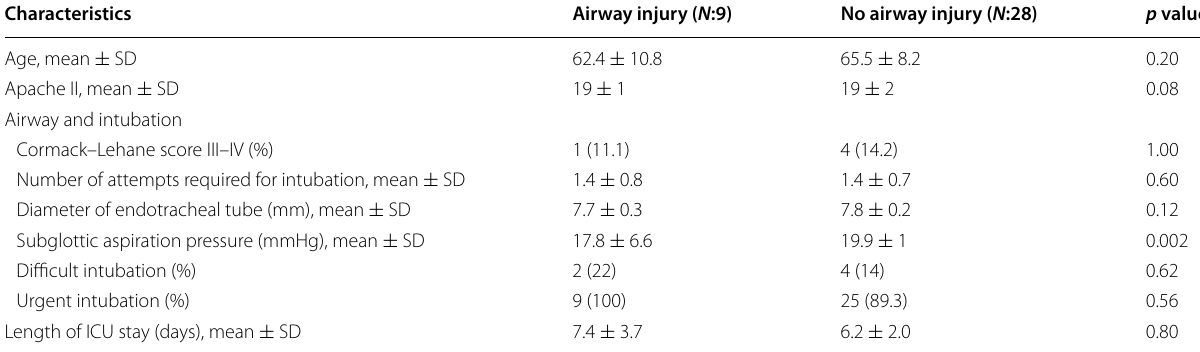
Table 5 Characteristics of patients with injuries detected at multidetector computed tomography